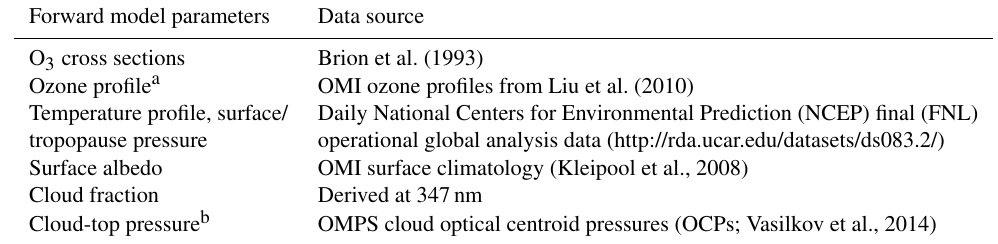
Table 1. Surface and atmospheric input parameters and cross section data used in forward model calculations.